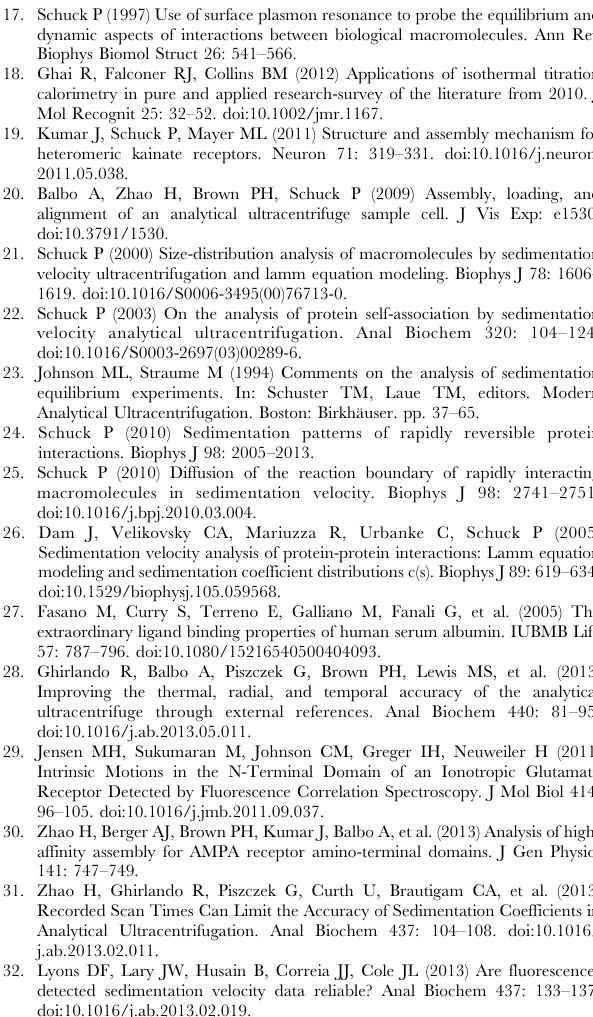
Table S1 Signal weighted-average sedimentation coefficient of FAM-GluA2 ATD in the presence of different concentrations of BSA.